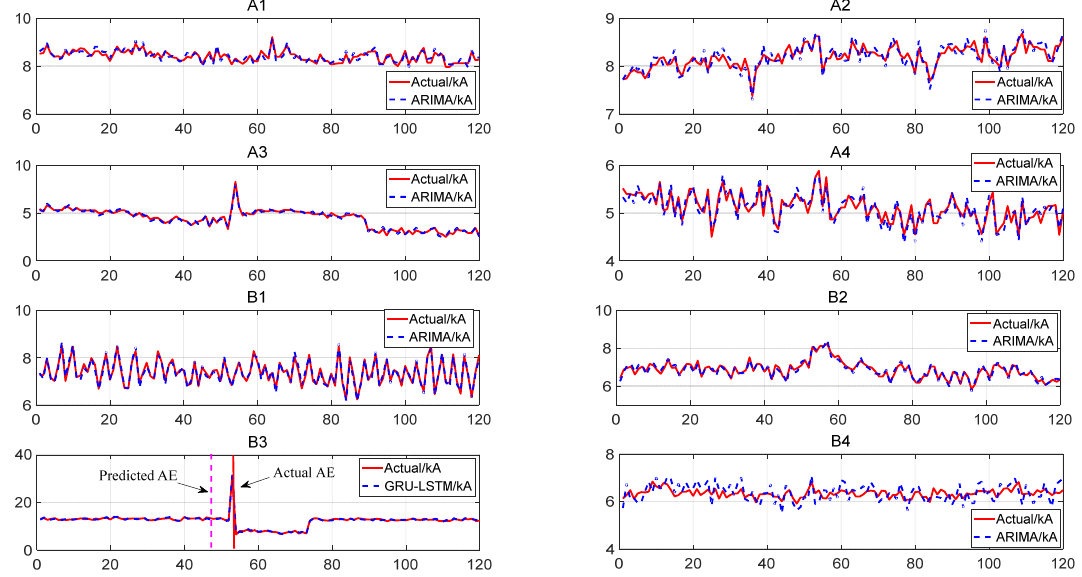
Figure 10. Area 1 anode rod current fluctuation diagram.